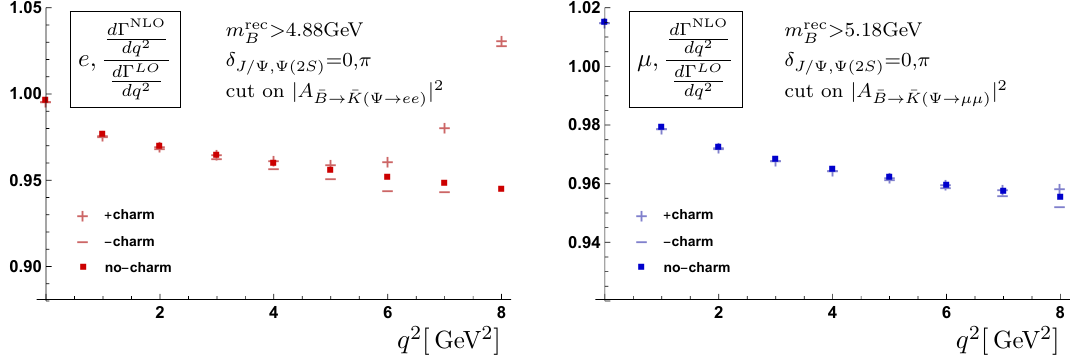
Figure 5 . Plots with the resonant mode cut out (cf. main text for explanation). For q 2 < 6 GeV 2 the interference effects are small, even in the electron case (confirming the plot in figure 4), and do not indicate any contamination to R in particular. The corresponding plot without the LO K normalisation can be found in appendix C in figure